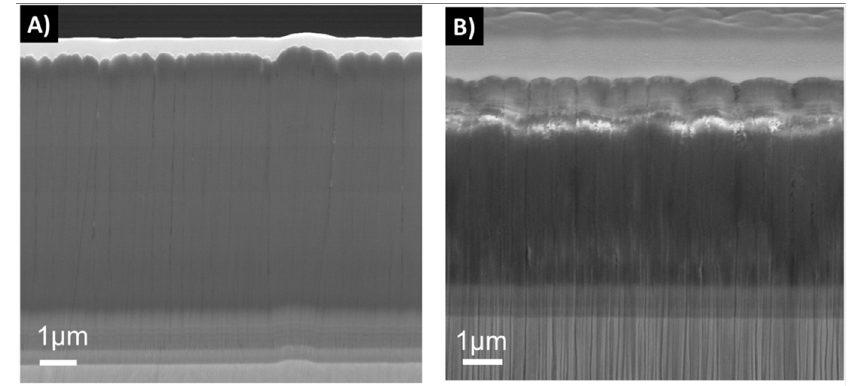
Figure 5. Cross sections from sample 3D-3f-H0-P3.4 before ( a ) and after ( b ) exposure to fetal bovine solution (FBS) showing surface morphology and coating layer cross sections.